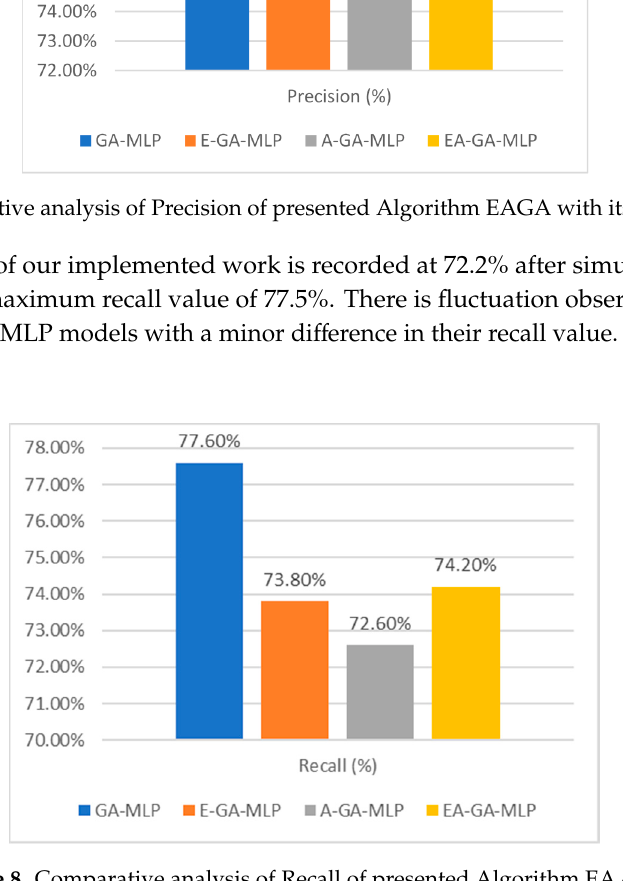
Figure 8. Comparative analysis of Recall of presented Algorithm EA -GA.